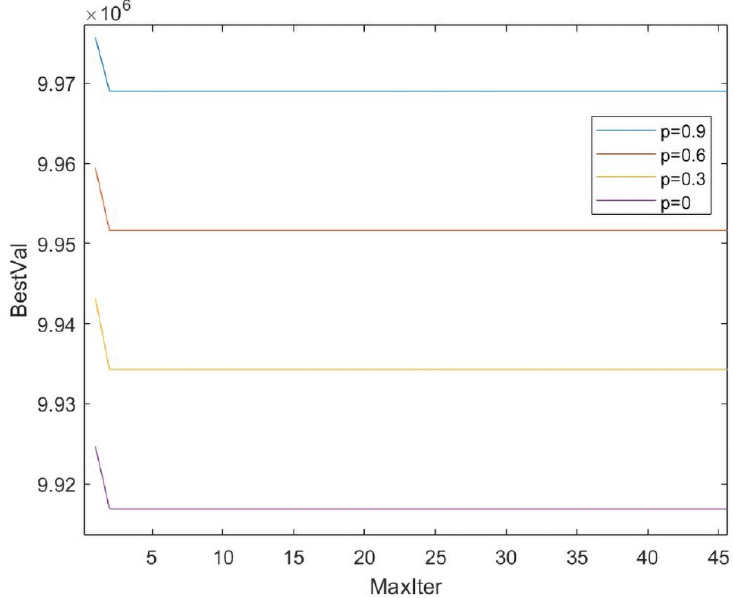
Fig. 4 Relationship map between defender loss and attacker degree of rationality change, site selection facilities of